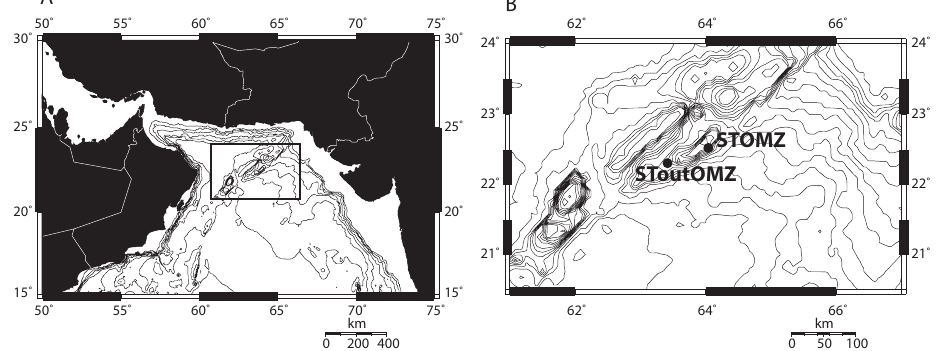
Fig. 1. The northern Arabian Sea (A) and the sampling areas STOMZ and SToutOMZ indicated on the Murray Ridge (B) after Pozzato et al.